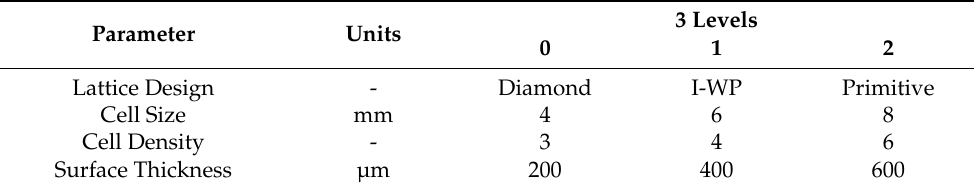
Table 2. Experimental design levels in actual and coded